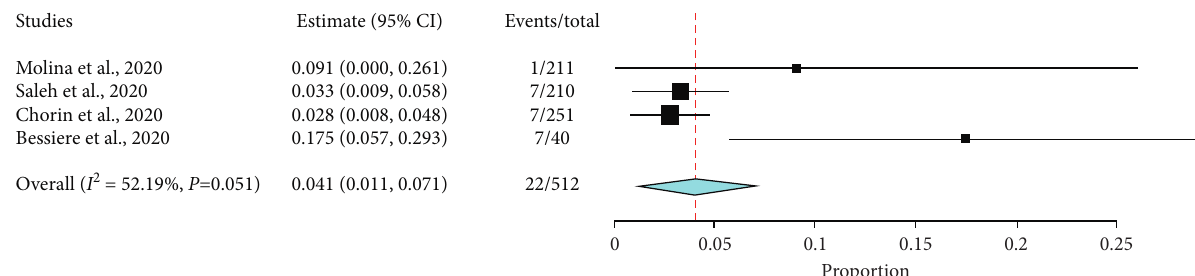
Figure 10: Proportion of patients’ drug discontinuation due to an increase of QTC prolongation ( > 500ms) in COVID-19 patients treated with HCQ with or without AZ.